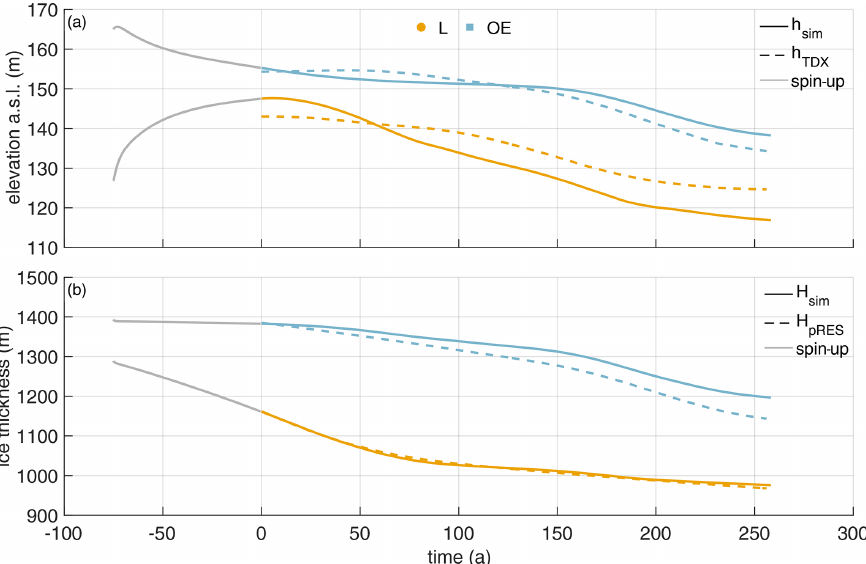
Figure 7. Second experiment: simulated surface elevation (a) and ice thickness (b) using the synthetic melt rate. Colors denote quantities above the channel (yellow) and outside the channel (blue). (a) Simulated surface elevation h sim (solid lines) and observed h TDX (dashed lines). (b) Simulated ice thickness H sim (solid lines) and observed H pRES (dashed lines). Gray lines represent the